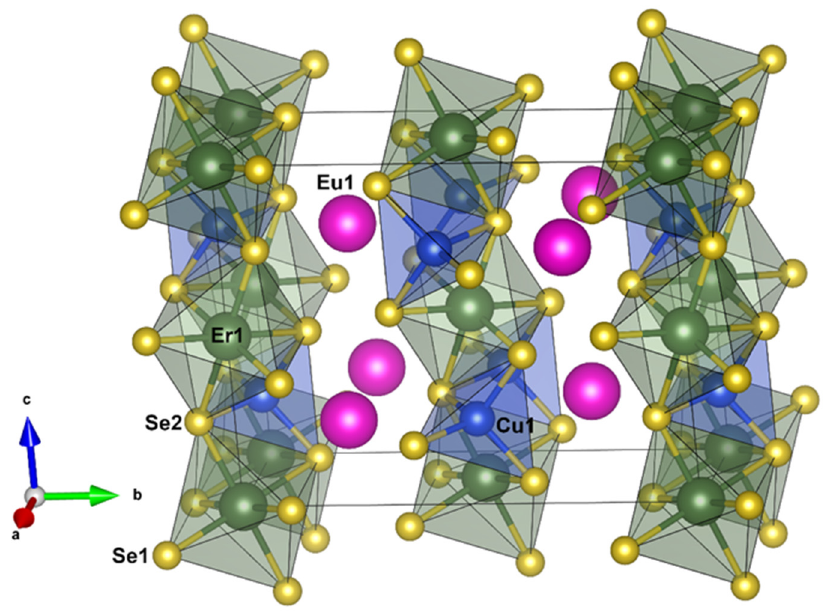
Figure 2. Crystal structure of EuErCuSe 3 .